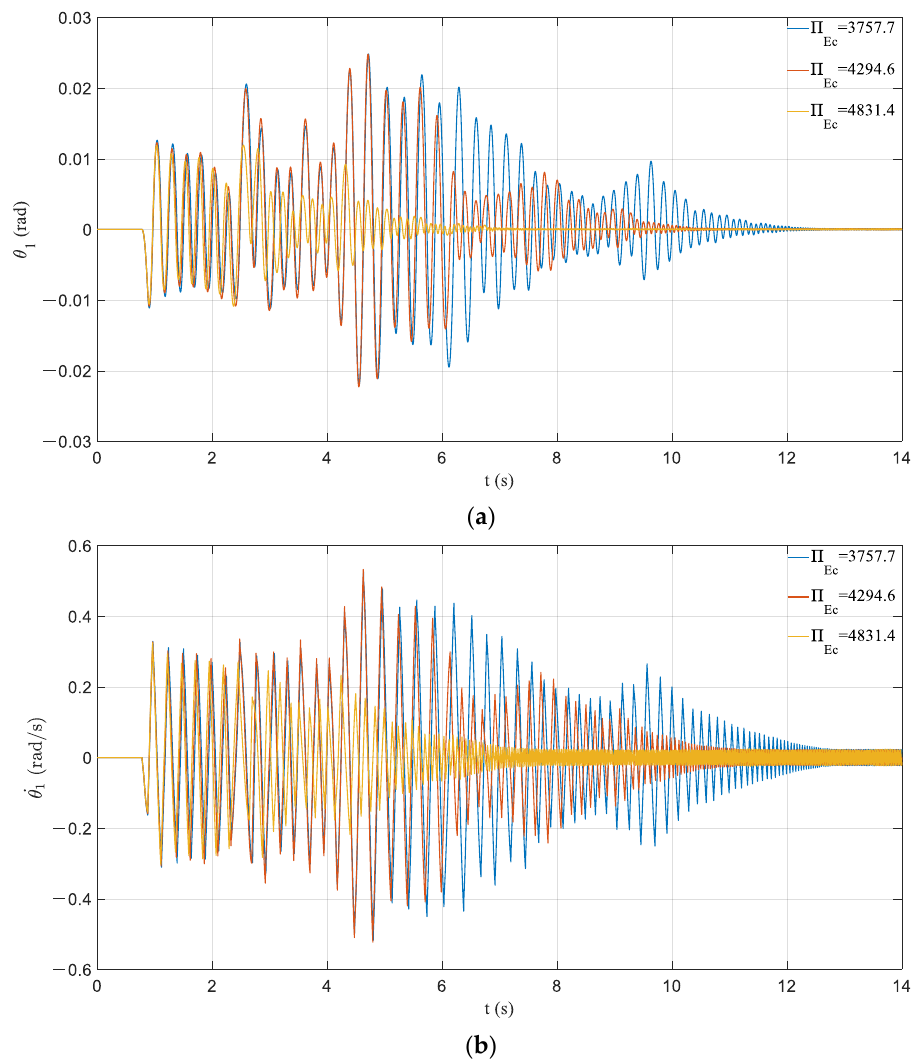
Π : ( a ) time history of rocking rotation; ( b ) time history of angular velocity. Figure 20. Ec